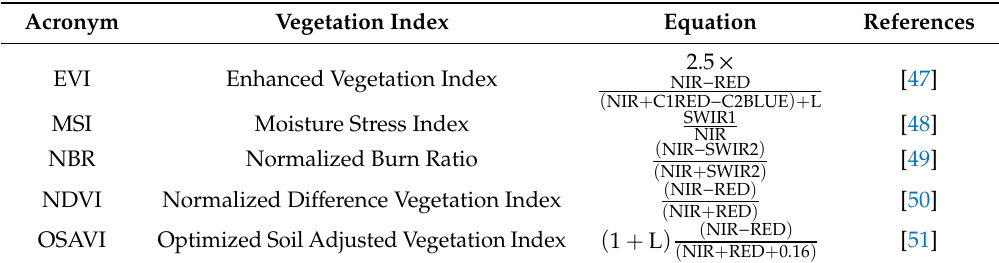
Table 1. Vegetation indices (VIs) considered in the study of Maritime pine stands in decline process in Sierra de Baza